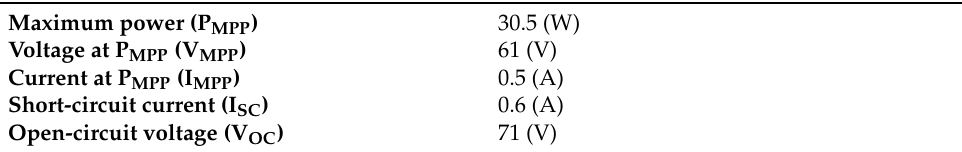
Table 4. Requirements for the PV module used.